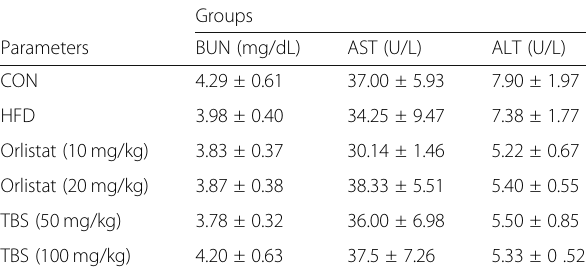
Table 1 Effect of TBS administration on blood biochemistry in HFD-induced